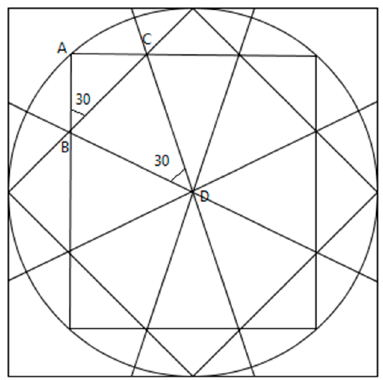
Figure 4. The fourth ornamentation. Appl. Sci. 2020 , 10 , x FOR PEER REVIEW